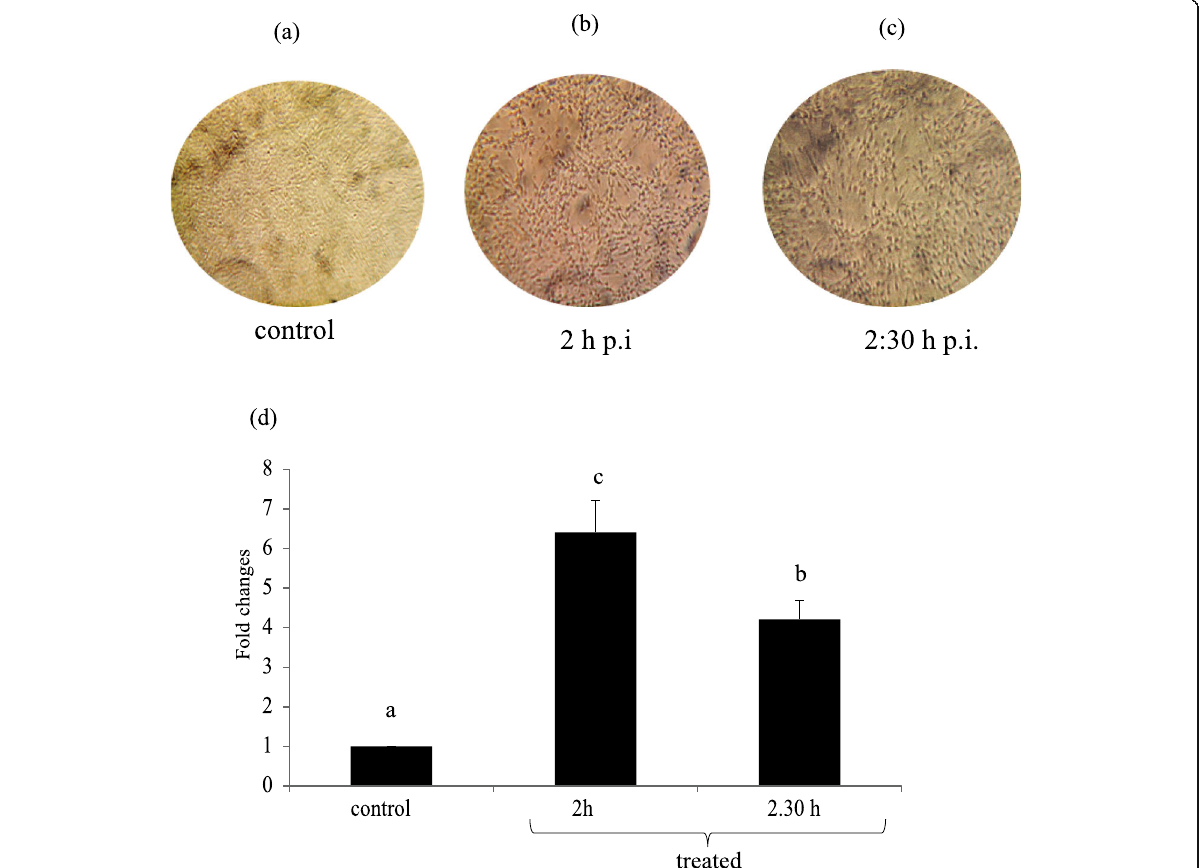
Fig. 9 Caspase-8 gene expression is induced in LRG cell line during cell death by A. hydrophila infection. Labeo rohita gill (LRG) cell line was cultured for 48 h, and then, it was either mock infected or A. hydrophila infected (at 1 MOI) for 2 h to 2.30 h. Then, control and treated cells were observed under microscope (× 10) to visualize the morphological changes. a Control, b at 2 h, and c at 2.30 h of A. hydrophila infection. d Total RNA was extracted from mock infected and A. hydrophila infected cells, and qRT- PCR was employed to investigate the expression of caspase-8 and β -actin gene. The caspase-8 gene expression has been normalized with the housekeeping gene β -actin and expressed as fold changes as compared to the control. The result has been expressed as mean ± standard errors